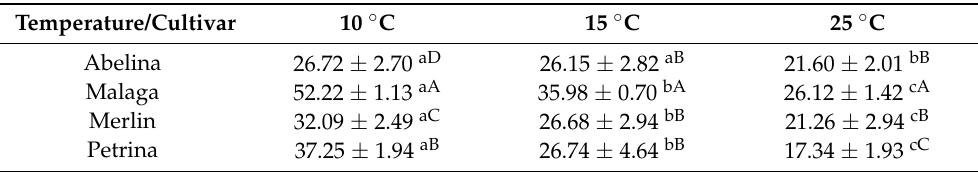
Table 3. Electrolyte leakage (%) from seeds of four soybean cultivars germinated for 48 h at different